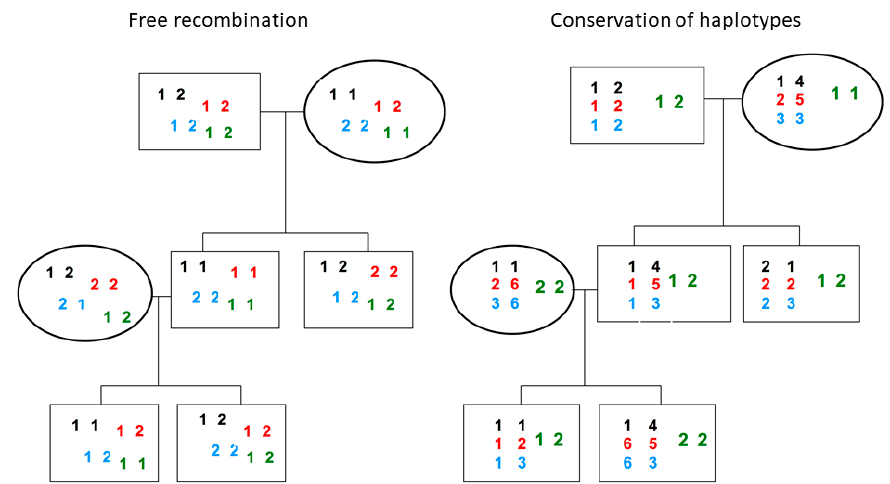
Figure 2. Stable segregation of ancestral haplotypes through three generation family trees. The left describes the inheritance pattern, where the loci are bi-allelic and segregate independently. The right describes the inheritance pattern within PFB, where the alleles are highly polymorphic and the four ancestral haplotypes have segregated predictably.